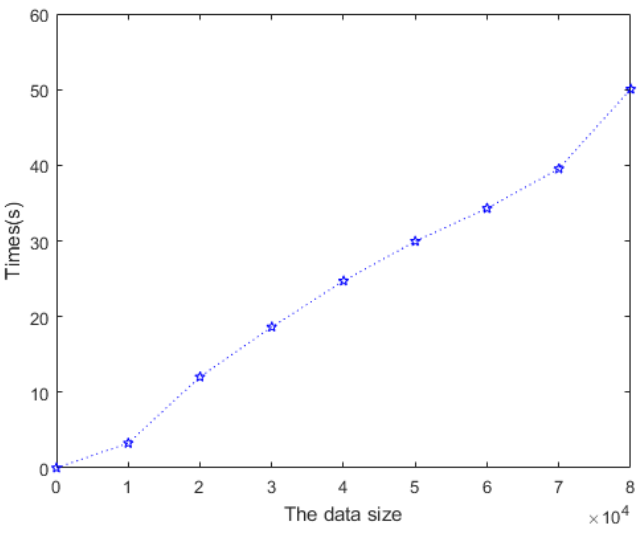
Figure 8. Delay of the cloning detection method.